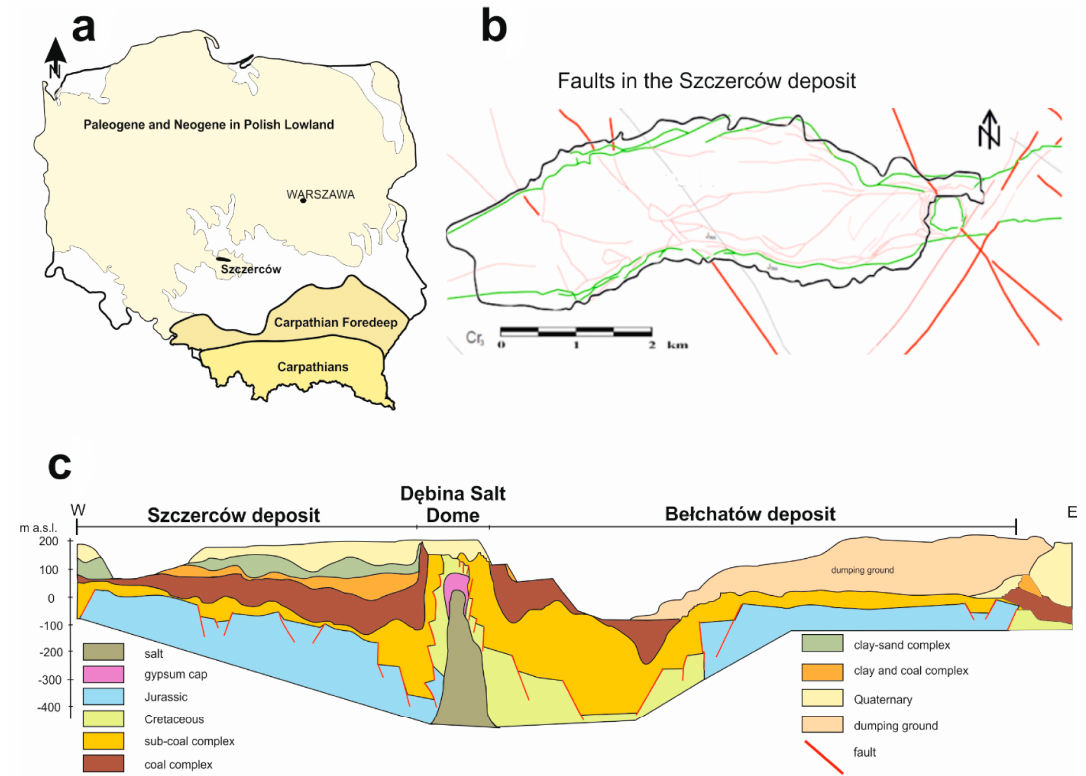
Figure 1. Location of Szczerc ó w deposits ( a ), tectonic map of the deposit ( b ), and geological cross-sections ( c ) according to Czarnecki et al. [13] and Kasi´nski et al. [19];